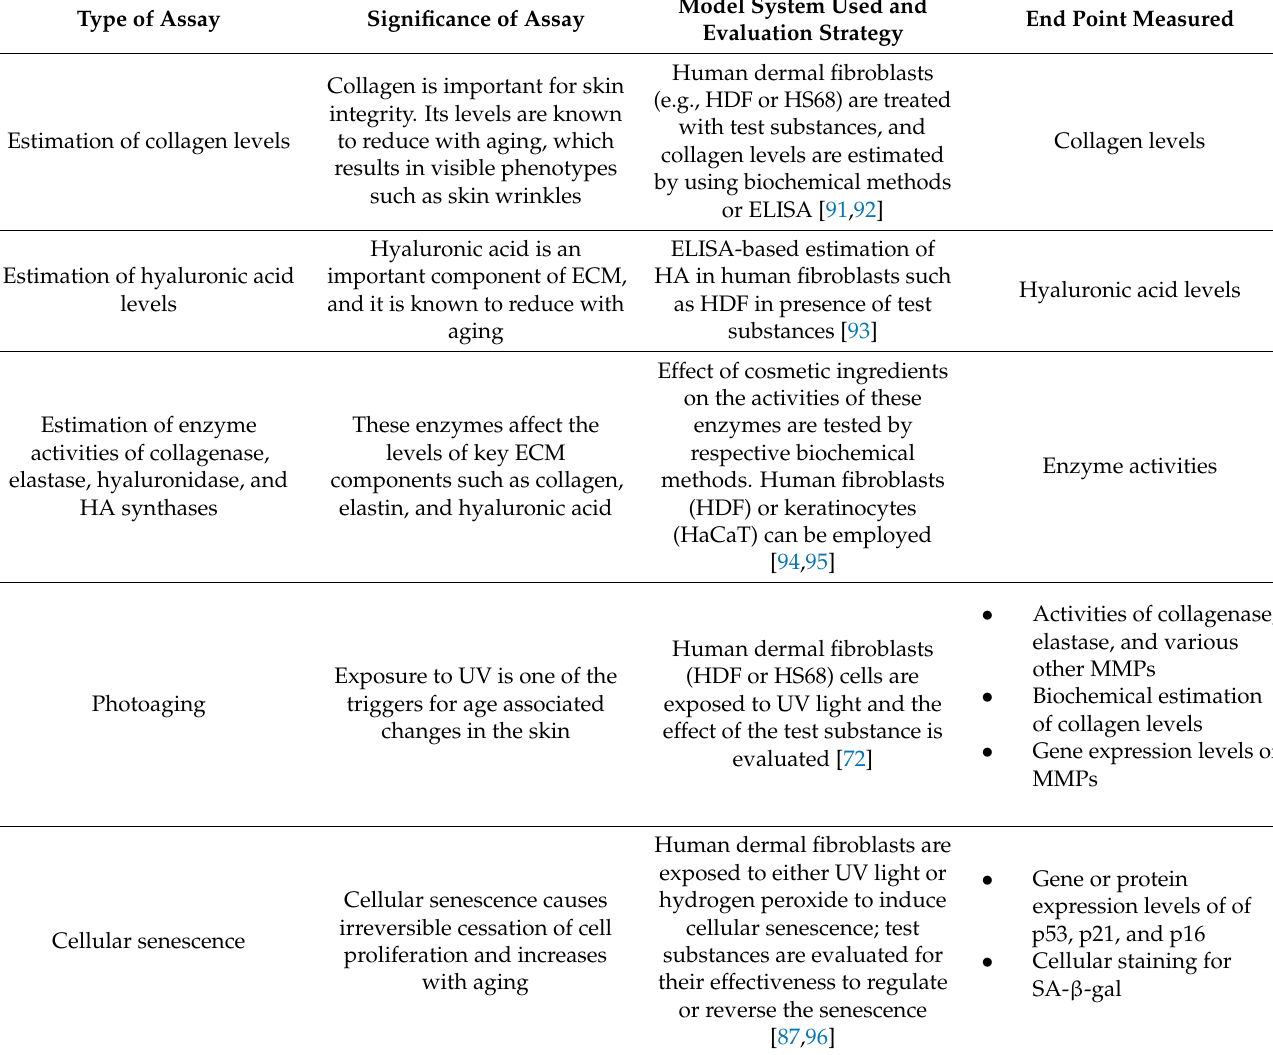
Table 3. Strategies for validation of